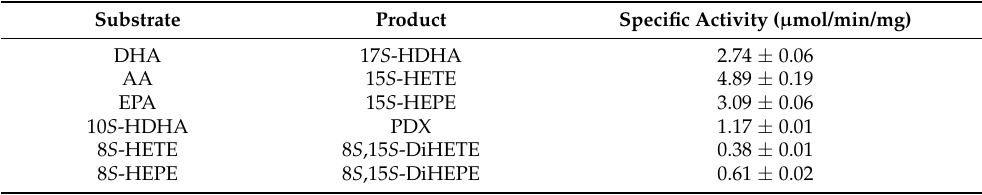
Table 2. Substrate specificity of BT 15 S LOX for PUFAs and HFAs.